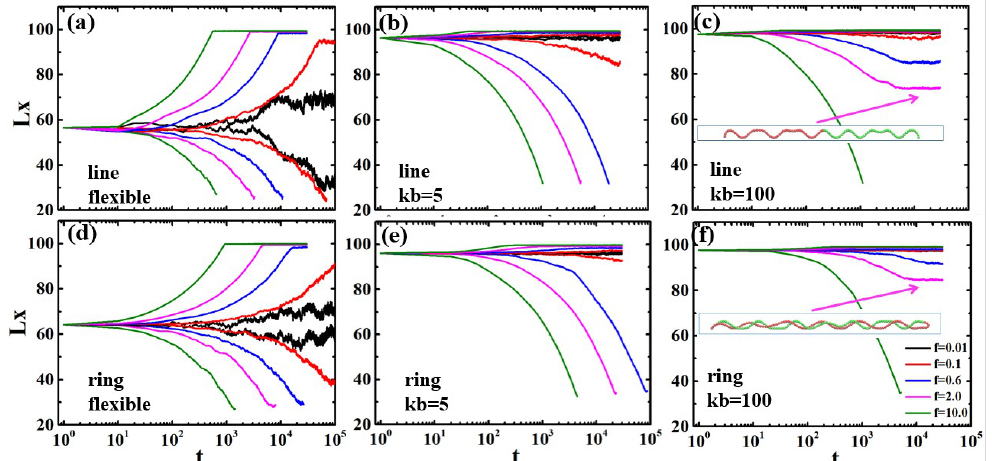
Figure 8. The lengths along the tube Lx as functions of time t for linear and ring polymers with different rigidities under external force f confined in channel diameter d = 5. ( a ) Flexible linear polymer; ( b ) Semiflexible linear polymer with k b = 5; ( c ) Semiflexible linear polymer with k b = 100; ( d ) Flexible ring polymer; ( e ) Semiflexible ring polymer with k b = 5; ( f ) Semiflexible ring polymer with k b = 100. The insert in ( c , f ) is the helix structures for linear and ring polymers,